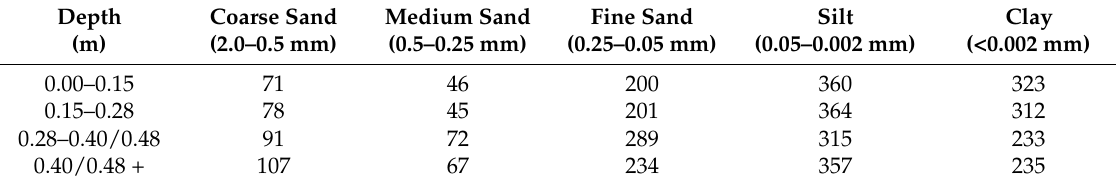
Table 1. Soil particle distribution (g kg − 1 ) of the profile pit at the experimental